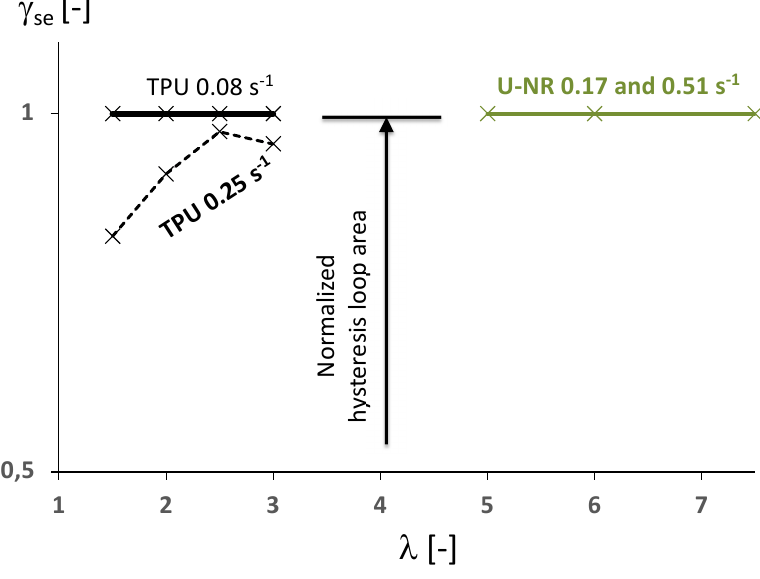
Figure 5. Energy characterization in terms of γ se versus stretch for the U-NR at 0.17 and 0.51 s − 1 (in green) and the TPU (in